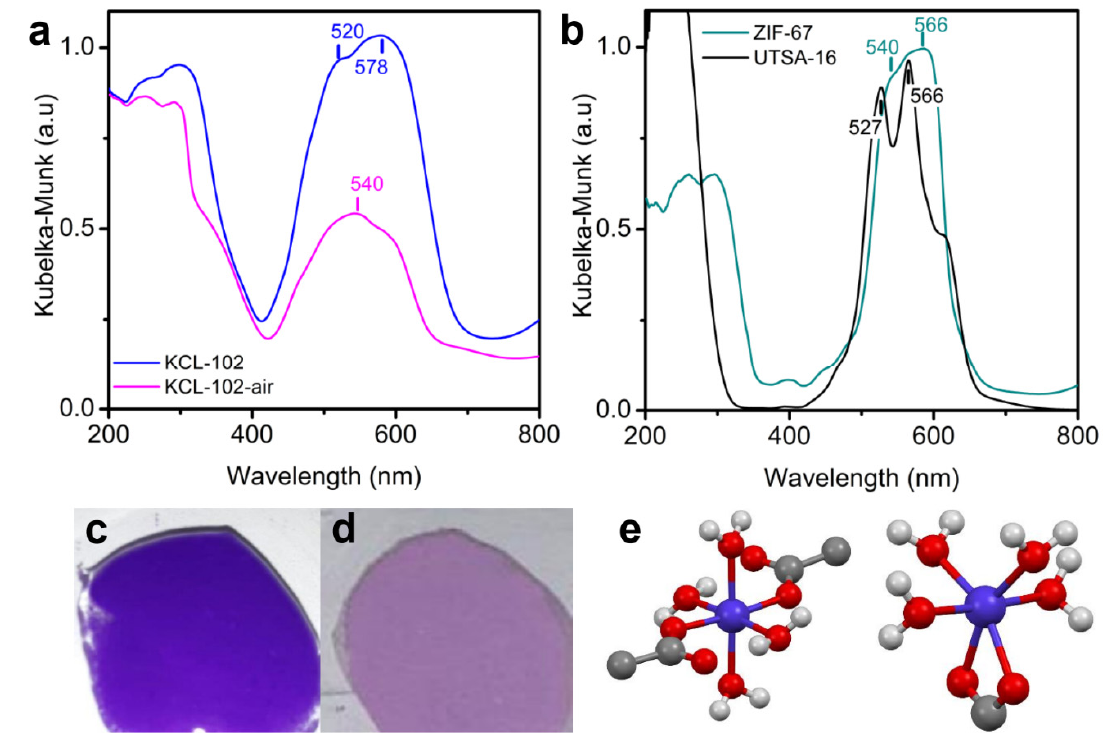
Figure 6. ( a ) DRUV-vis spectra of KCL-102 (blue line) and KCL-102-air (magenta). ( b ) DRUV-Vis spectra of ZIF-67 (green line) and UTSA-16 (black line, from Ref. [32]). All the spectra were recorded in the air. ( c , d ) Photographs of the KCL-102 ( c ) and the KCL-102-air ( d ) samples. ( e ) First coordination environment of cobalt centers in KCL-102-air as in the experimental structure reported in Ref. [46]. Color atom code: violet (Co), red (O), grey (C), white (H).